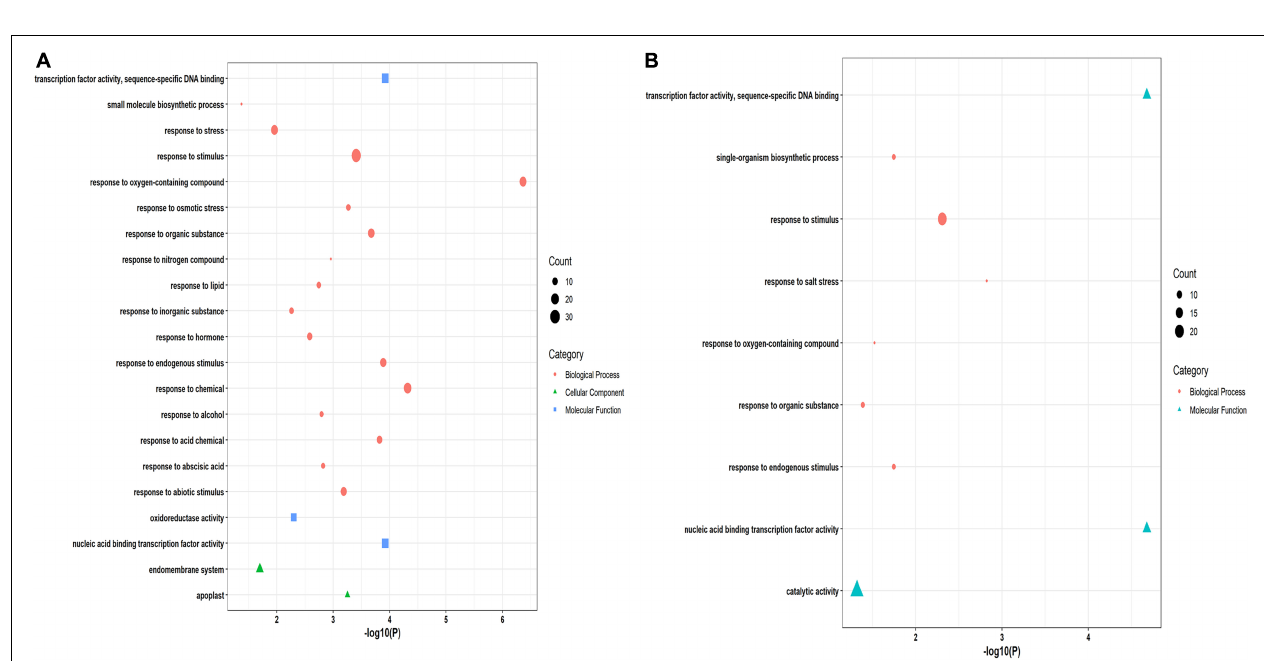
FIGURE 6 | Gene ontology (GO) classification of hub genes in (A) drought (B) salt stress condition. The x-axis represents significant P -values. The y-axis denotes the enriched functions. Bubble size denotes the number of DEGs enriched in the putative functions.